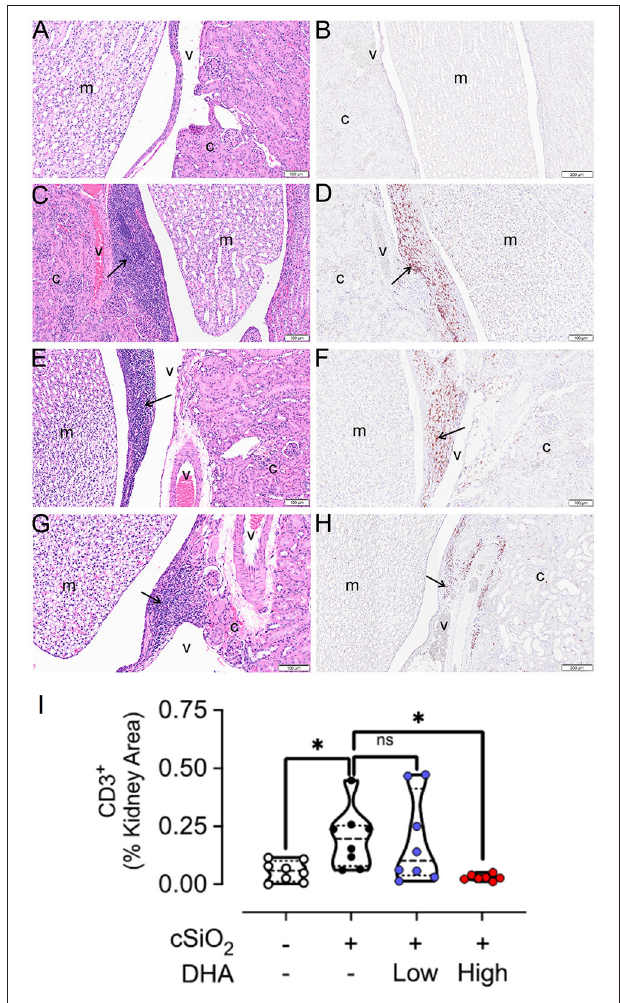
FIGURE 11 | High DHA diet suppresses cSiO 2 -induced CD3 + T cell infiltration into the kidney. Light photomicrographs of hematoxylin and eosin-stained renal tissue sections (A,C,E,G) from the hilar region and light photomicrographs of kidney tissue sections immunohistochemically stained (arrows) for CD3 + T cells (B,D,F,H) . Kidneys taken from mice at 13 weeks after the final intranasal saline intranasal instillation and fed control diet (Veh/CON, A,B ), cSiO 2 instillation and fed control diet (cSiO 2 /CON, C,D ), cSiO 2 instillation and fed 0.4% DHA diet (cSiO 2 /low DHA, E,F ), and cSiO 2 instillation and fed 1.0% DHA diet (cSiO 2 /high DHA, G,H ).Lymphoid cell accumulations (arrows) in the interstitial tissue adjacent to interlobular blood vessels (v) in the renal cortex (c) (C,E,G) ). Marked perivascular accumulation of lymphoid cells in the renal cortex (c) from cSiO 2 /CON mouse (C) . Moderate, mild and no perivascular accumulations of lymphoid cells in the kidneys of cSiO 2 /low DHA (E) , cSiO 2 /high DHA (G) , and Veh/CON (A) mice, respectively. Marked perivascular accumulation of CD3 + T cells (arrows) in kidney of cSiO 2 /CON mouse (D) . Moderate, minimal and no perivascular accumulations of T lymphoid cells in the kidneys of cSiO 2 /low DHA (F) , cSiO 2 /high DHA (H) , and Veh/CON (B) mice, respectively. m, medulla of the renal papilla that extends into the renal pelvis. (I) depicts the percentage of CD3 + renal tissue. Statistical comparisons were performed as described in the Methods section. * p ≤ 0.05, ns = not significant.